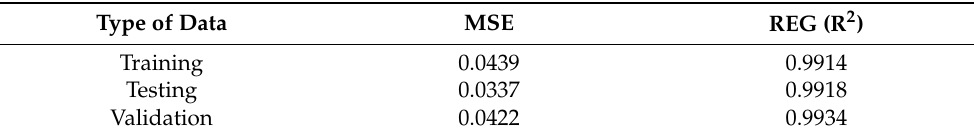
Table 5. Statistical values of purposed ANN model.